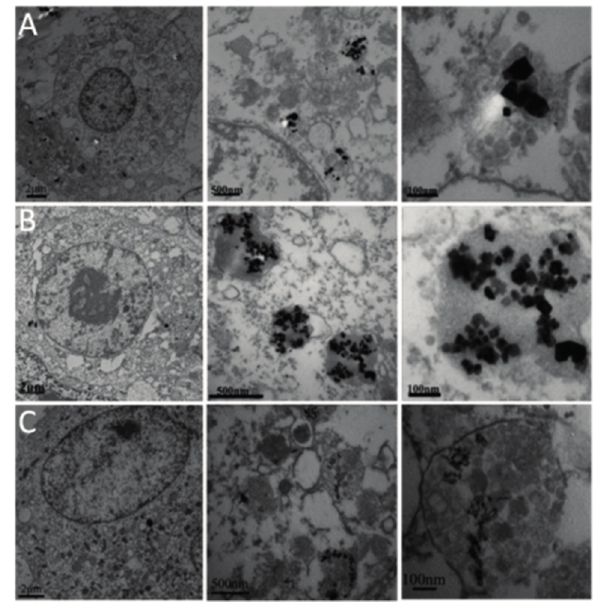
Figure 3. Photomicrographs of HepG2 cells with 50 μ g/mL nano-CeO 2 demonstrating significant changes in cellular morphology.